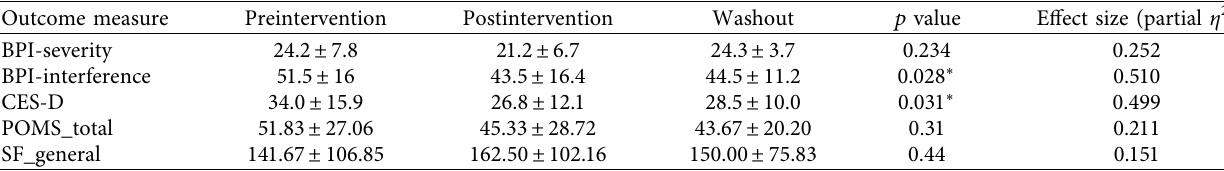
Figure 2: Summary of poststudy interview. (a) Overall experience of patients. (b) Response to use the intervention again. (c) Common answers to the open-ended question about positive effects. (d) Common answers to the open-ended question about negative effects. Table 3: Comparison of mean scores across time for all responders ( n �